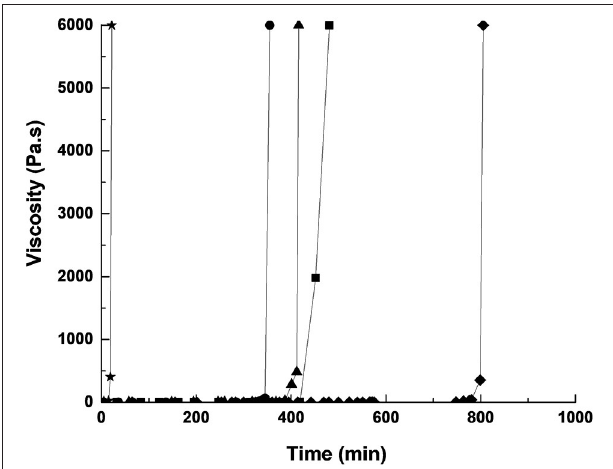
FIGURE 2 | Viscosity values of the reactive mixtures as function of time, with SM1 ( (cid:4) ), SA3M1Sb1 ( N ) and SA5M1Sb2 ( (cid:8) ), ( (cid:7) ) SA3 and ( ⋆ ) SA5 samples.